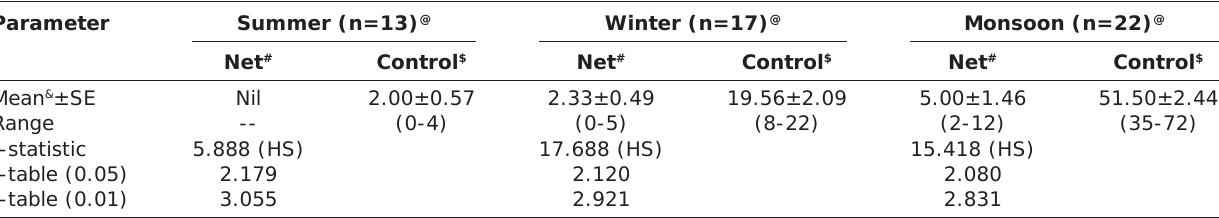
Table-1: Reduction in the Culicoides midges population in fly proof shed. Parameter